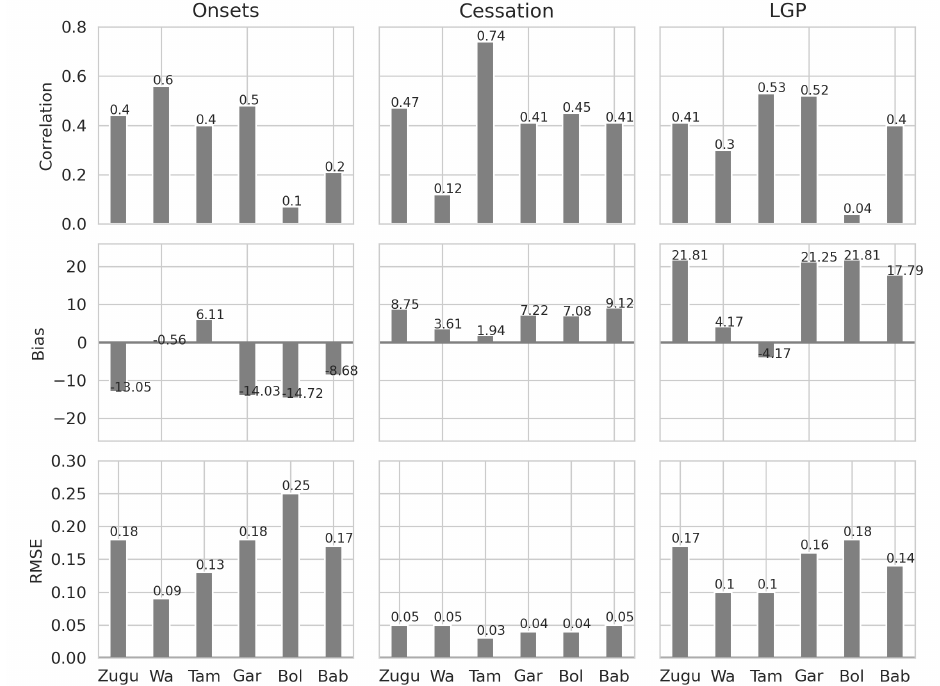
Figure 7. Agreement between CHIRPS-v2 and gauge data in representing the rainfall onset, cessation, and LGP at the six stations from 1981 to 2016. Performance was measured using Pearson correlation (r), Bias, and root-mean-square errors (RMSE). Station names are like Figure 6. In contrast, relatively high RMSE values (0.14–0.18) were observed in the remaining stations. Although CHIRPS-v2 showed good skill in capturing the rainfall indices